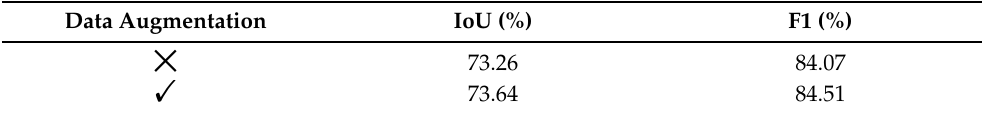
Table 5. Comparative study of data enhancement. (cid:35) and (cid:33) denote our use and non-use of data augmentation strategies,